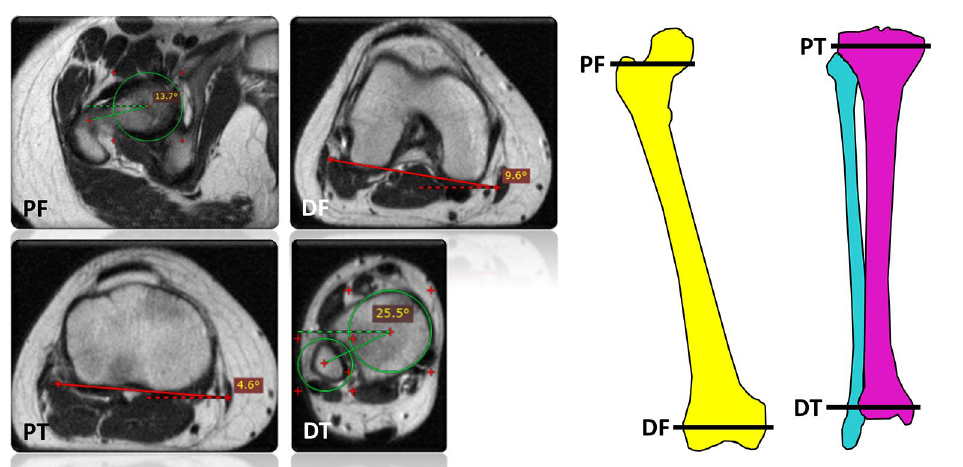
Figure 2. Manual reference measurements to determine femoral and tibial torsion at the levels of the hip, knee, and anke. Anatomic landmarks were used to define the reference lines at the hip in line with the method suggested by Lee ( PF proximal femur). The reference lines at the knee were delineated as the distal femoral reference line ( DF distal femur) and as the proximal tibial reference line ( PT proximal tibia), while the reference line at the ankle was determined using the ellipses method ( DT distal tibia). The circles indicate the (superimposed) femoral head and ellipses along the medial malleolus and fibular notch, while dotted lines visualize the horizontal reference lines. Schematics of femur (yellow), tibia (purple), and fibula (light blue) on the right indicate the levels of the axial images. 12-year-old female. Please refer to Supplementary Figure 3 for a visualization of the other manual reference methods to determine femoral torsion (according to the Reikeras, Tomczak, and Murphy methods) and tibial torsion (according to the bimalleolar and talus